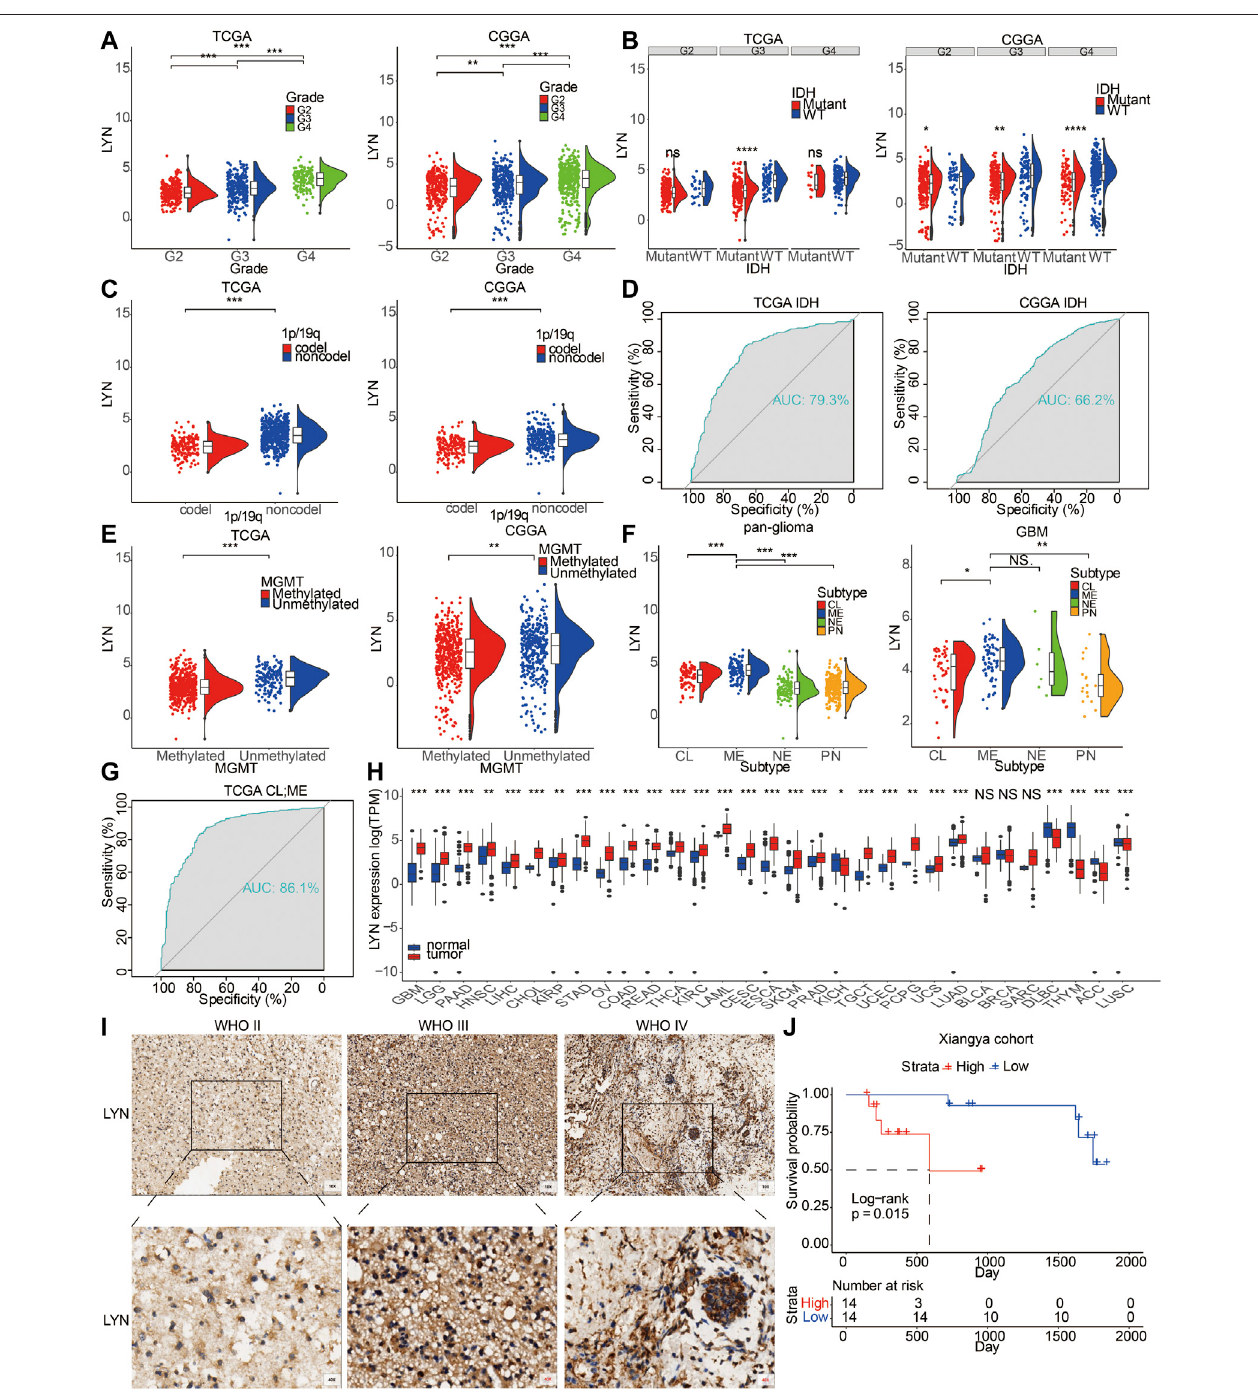
FIGURE 1 | LYN expression correlated with diverse pahological characteristics (A) . LYN expression in different WHO grades in TCGA and CGGA (B) . LYN expression in different IDH state in TCGA and CGGA (C) . LYN expression in different 1p/19q status from TCGA and CGGA dataset (D) . ROC curves showed LYN as a predictor of IDH mutation (E) . LYN expression in different MGMT promotor status from TCGA and CGGA dataset (F) . LYN expression in GBM samples and glioma samples based on molecular subtypes in TCGA (G) . ROC curves of LYN in predicting classical and mesenchymal subtype glioma (H) . LYN expression in different cancers from TCGA dataset. * p < 0.05, ** p < 0.01, *** p < 0.001 (I) . Immunohistochemistry staining results of LYN in Xiangya cohort (J) . Kaplan — Meier curve of overall survival in Xiangya cohort based on the staining intensity of LYN. p -value was obtained from the log-rank test.